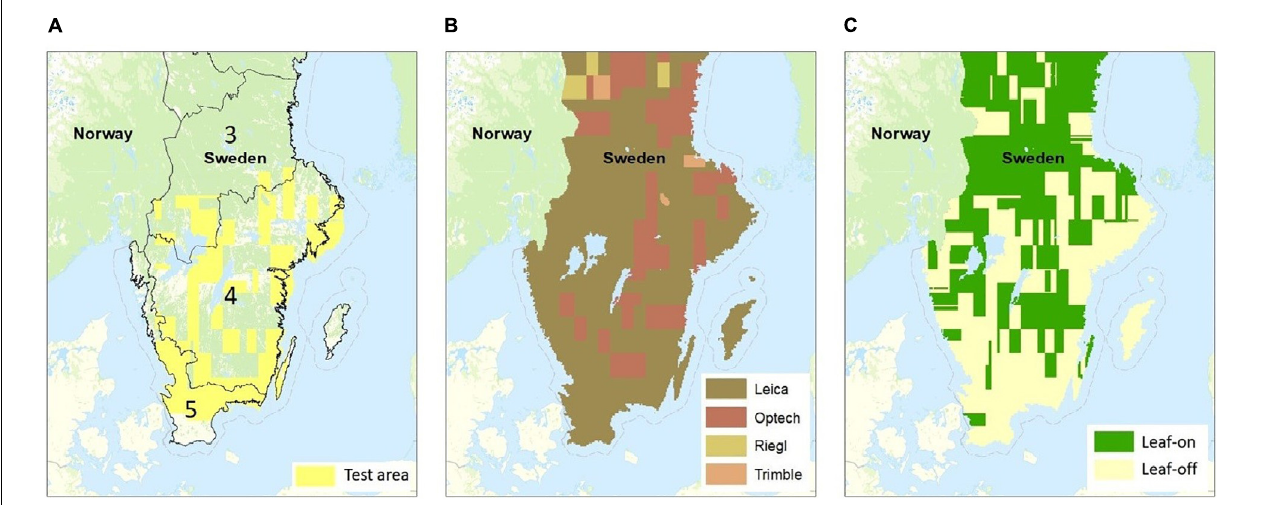
FIGURE 1 | Test area (A) , scanner brand (B) , and scanning season (C) . Three of the strata used in the Swedish NFI are shown in (A) (strata 3, 4, and 5). These strata roughly correspond to the vegetation zones: (3) southern-middle boreal; (4) mainly hemiboreal; and (5) temperate. Copyright Lantmäteriet.